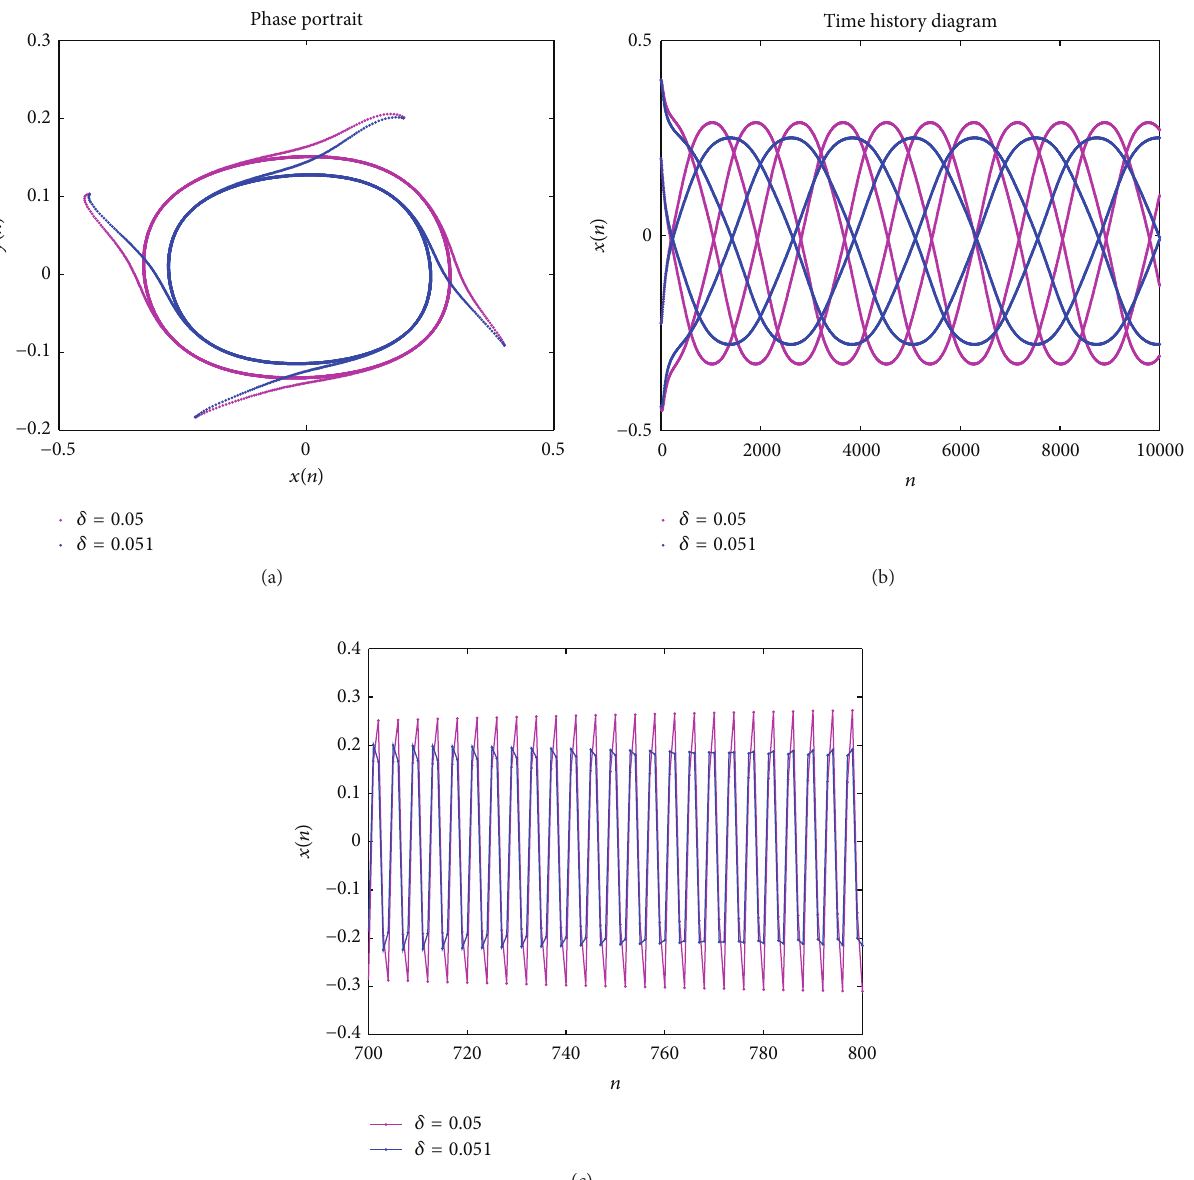
Figure 6: (a) Phase portrait and (b) time history diagram of stochastic discrete-time hyperchaotic system (6) with 𝛿 = 0.05 and 𝛿 = 0.051 . (c) Local amplification corresponding to